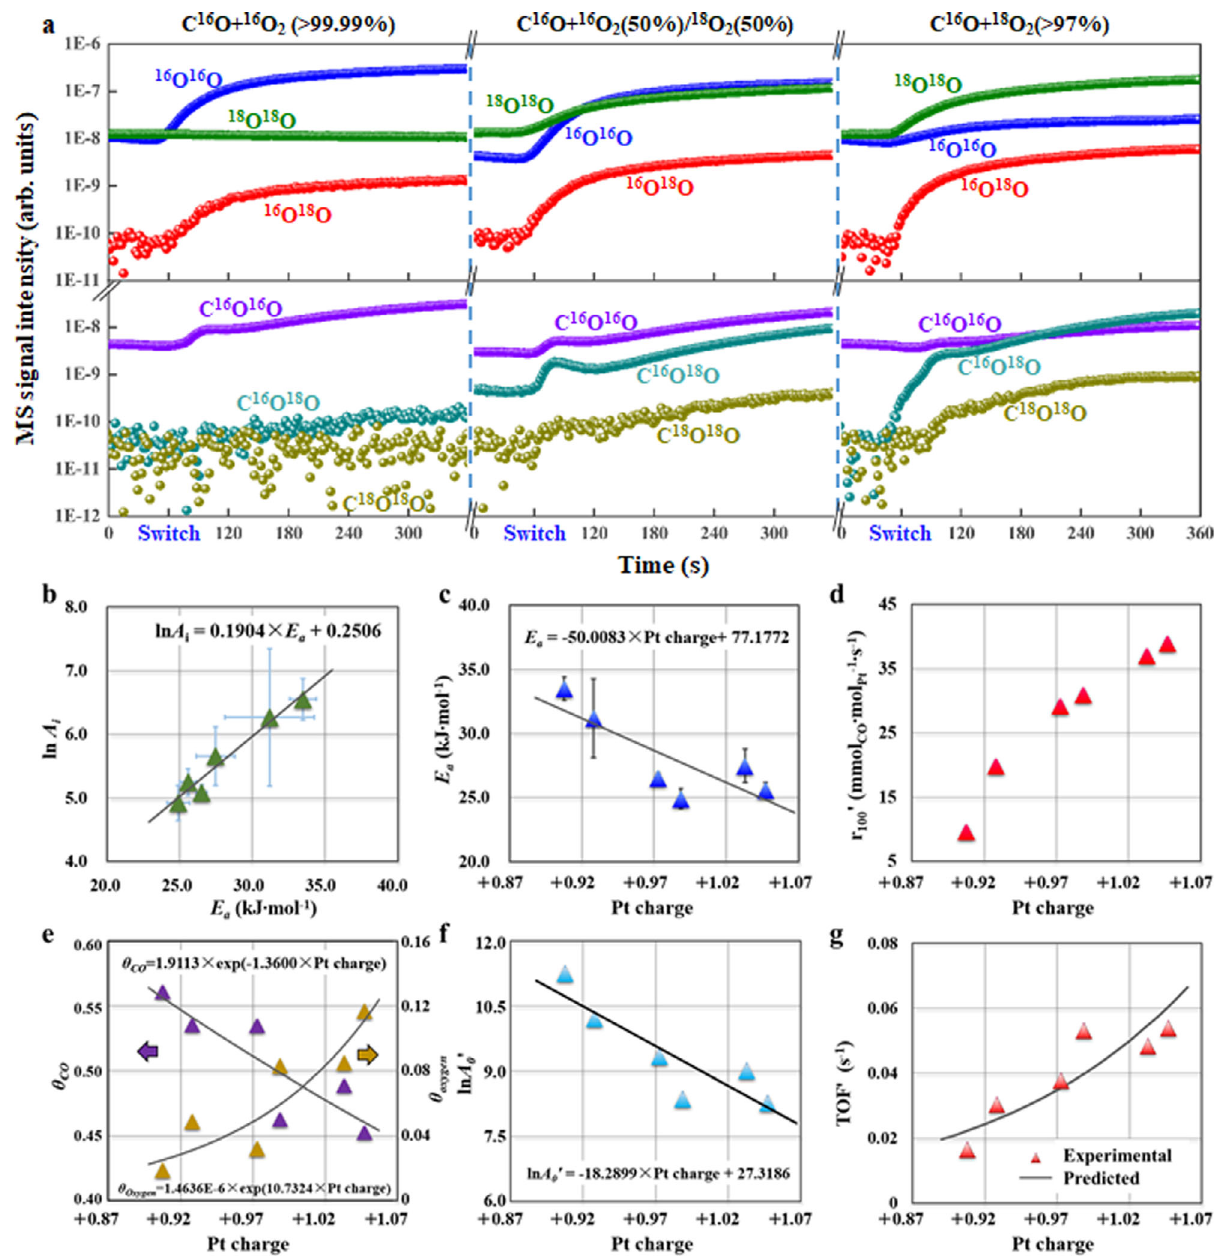
Fig. 4 Isotopic labeling studies and SSITKA of CO oxidation. a Mass spectrometry (MS) data collected for the Pt/CNT-600 catalyst during the switch from Ar to Ar + C 16 O + 16 O 2 (the purity is >99.99%), Ar + C 16 O + 16 O 2 (50%)/ 18 O 2 (50%), and Ar + C 16 O + 18 O 2 (the concentration of 18 O 2 is > 97%) at an ambient pressure. b The relationship between logarithm of frequency factor (ln A i ) and activation energy ( E a ). The E a ( c ), r 100 ’ ( d ), site coverages of CO ( θ CO ) and oxygen ( θ oxygen ) ( e ), logarithm of frequ e ncy factor (ln A 0 ’ ) ( f ), as well as the experimental and predicted TOF ʹ ( g ) as a function of Pt charge